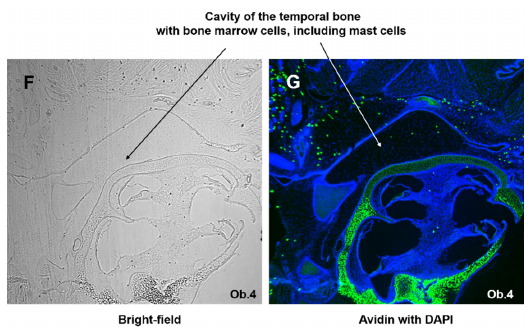
Figure 1. Avidin-positive MCs (mast cells) are present in the cochleae of mice and rats. MOUSE: Low ( A ), medium ( B ) and high ( C ) magnification of whole cochlear (p3 mice, n = 6) paraffin-embedded sections (10 µm) labeled with avidin-AlexaFluor-488 (green) and DAPI (blue). Avidin-positive MCs in scala vestibuli and modiolus; nuclei counterstained with DAPI. ( C ). Enlarged images of various cochlear MCs ( a – e from panel C ); scale bar 20 µm. RAT: Low ( D ) and medium ( E ) magnification of whole cochlear (p3 rat, n = 6) paraffin-embedded sections (10 µm) labeled with avidin-AlexaFluor-488 (green) and DAPI (blue). Avidin-positive MCs are visible in modiolus and the spiral ligament. Scale bar 50 µm. SM—scala media, ST—scala tympani, SV—scala vestibuli. There is visible staining of cartilage due to the known affinity of avidin to cartilage tissues [34]. Low magnification of bright field ( F ) and fluorescent field ( G ) representing paraffin-embedded sections (10 µm) labeled with avidin-AlexaFluor-488 (green) and DAPI (blue). The micrograph of the bright field demonstrates that the mast cells are localized to the cochlear bone tissue, which is not visible when using